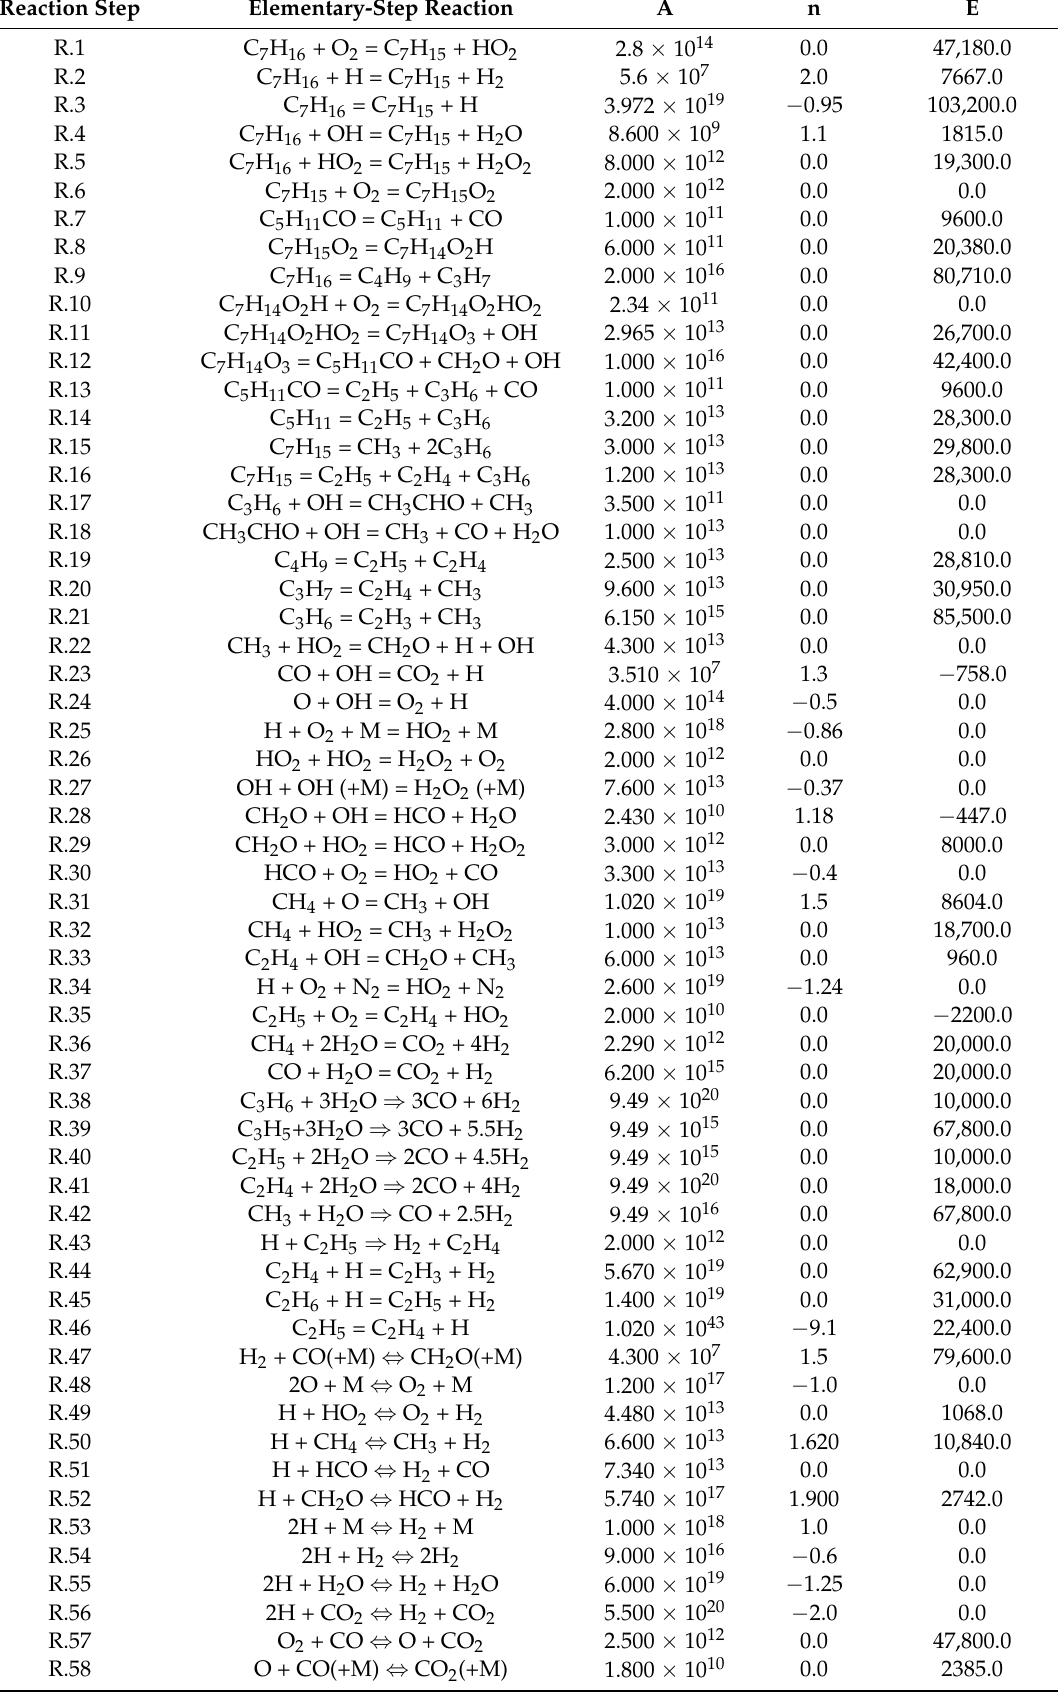
Table 1. Significant reactions and related rate constant expressions for n -heptane gas phase